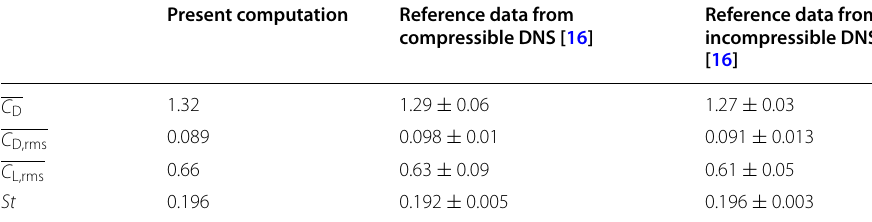
Table 1 Comparison of the force coefficients